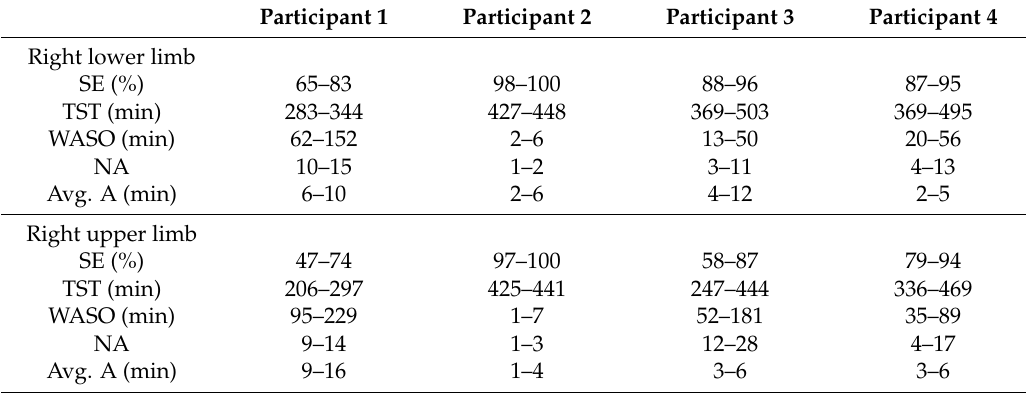
Table 2. Actigraph readings across participants with simultaneous limb placement (rounded off to nearest whole